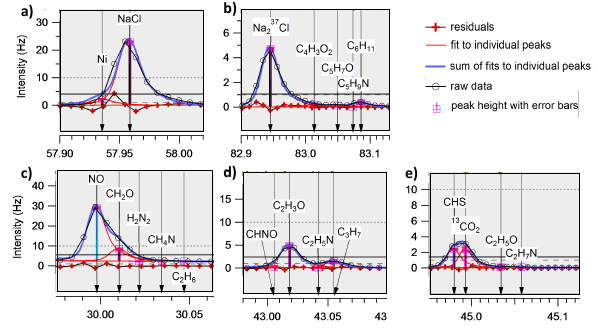
Fig. 10. HR ion fragment fits for two inorganic species and 3 organic species of the sea spray PMF factor in the difference